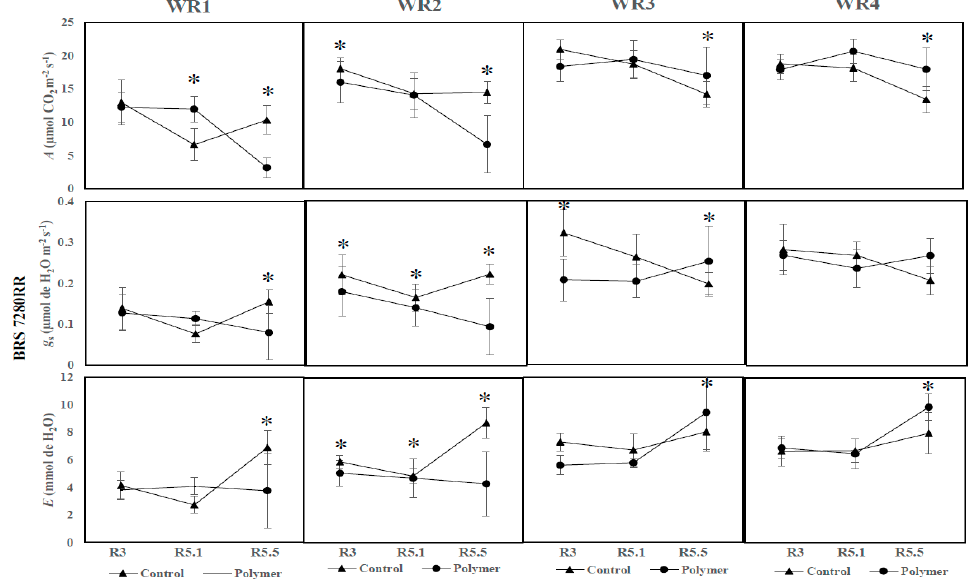
Figure 6. Photosynthesis, ( A ), stomatal conductance ( g s ) and transpiration ( E ) under four water regimes (WR) in three phenological stages of soybean with and without polymer supply (WR1 167 mm, WR2 237 mm, WR3 341 mm, WR4 534 mm) for the BRS 7280RR cultivar, in 2017. * indicates significant differences between the control and polymer treatments within each WR and phenological phase by Tukey’s test ( p <